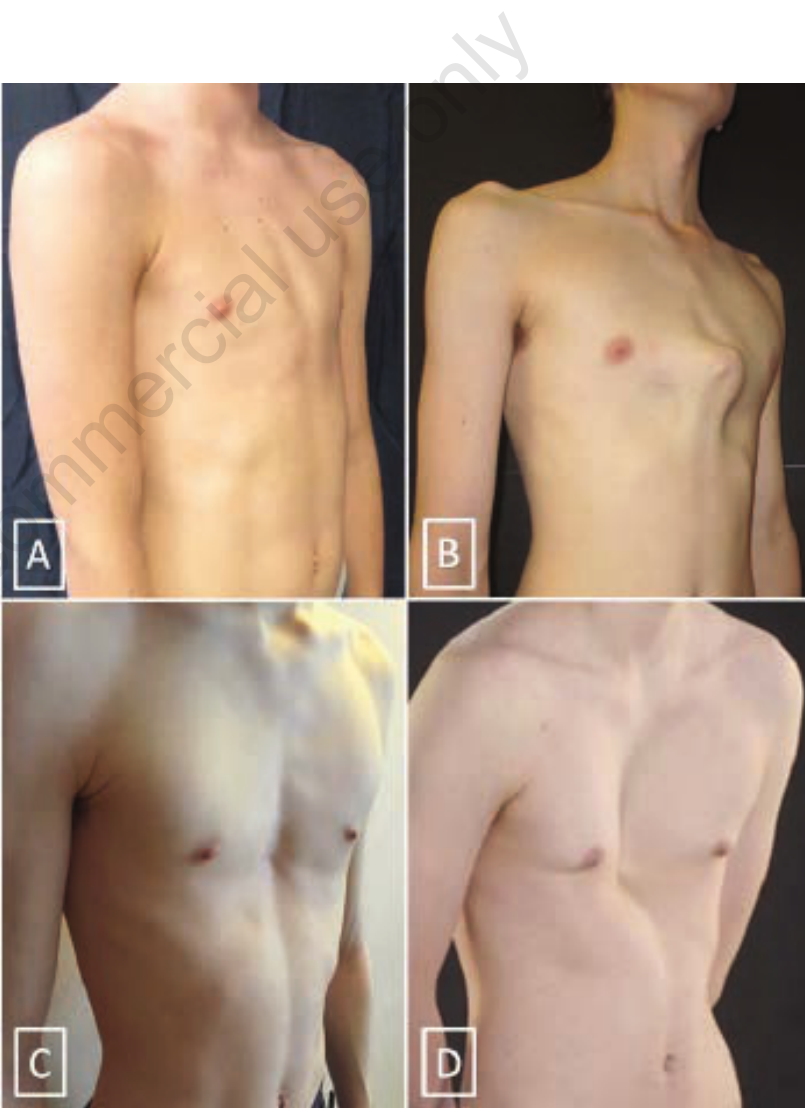
Figure 1. Mild (A) and severe (B) cases of pectus carinatum and mild (C) and severe (D) cases of pectus